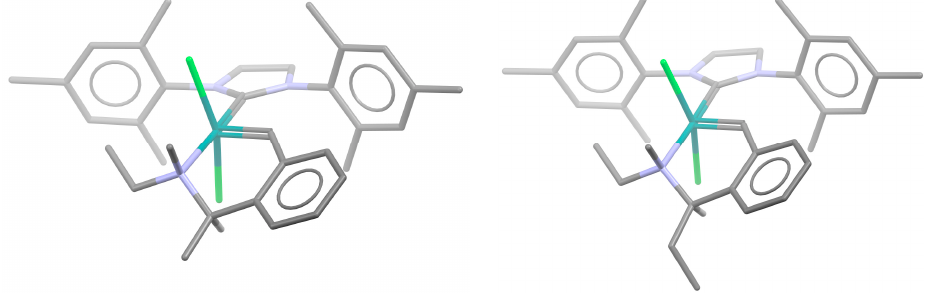
Figure 2. N–Ru complexes 4b (on the left ) and 5b (on the right ) with two stereogenic centers. All H-atoms except for the one in the α-CH-fragment are omitted everywhere for clarity.